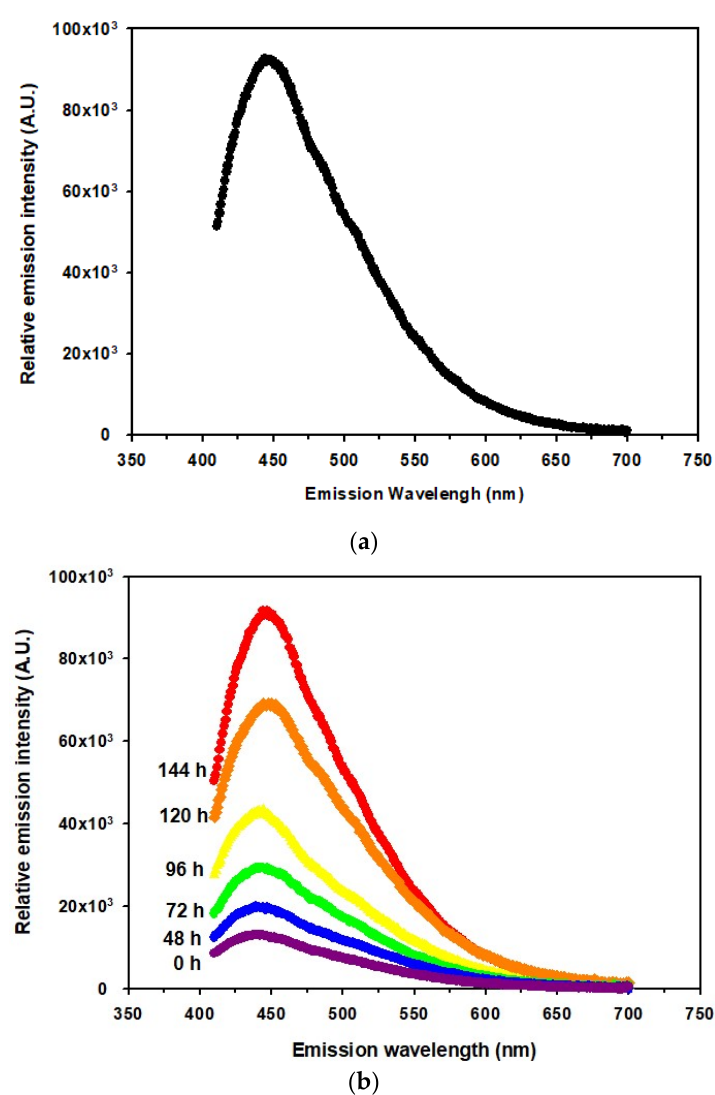
Figure 2. Fluorescence emission spectra of the dark brown pigment in the protein fraction. ( a ) Emission spectrum of the dark pigment fraction scanned by a fluorospectrophotometer with an excitation wavelength of 380 nm. ( b ) Fluorescence spectra of the pigment fractions for relative quantification of the brown pigment, which increased in a time-dependent manner under the same conditions. The fluorescence intensity of every fraction was measured with the following time points: initial 0 h, purple; 48 h, blue; 72 h, green; 96 h, yellow; 120 h, orange; 144 h, red.